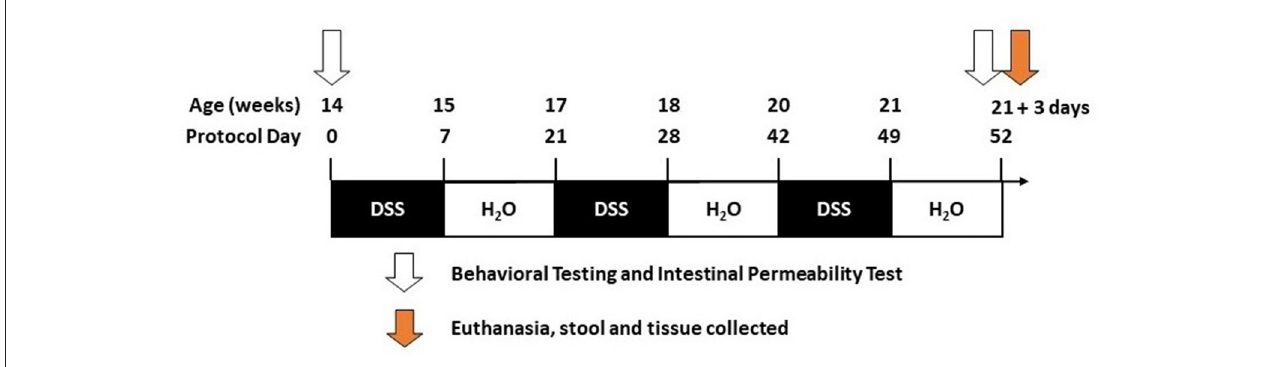
FIGURE 1 | Timeline. The diagram illustrates the dextran sodium sulfate (DSS) treatment over given over three cycles during the 52 days of the study (see Methods).